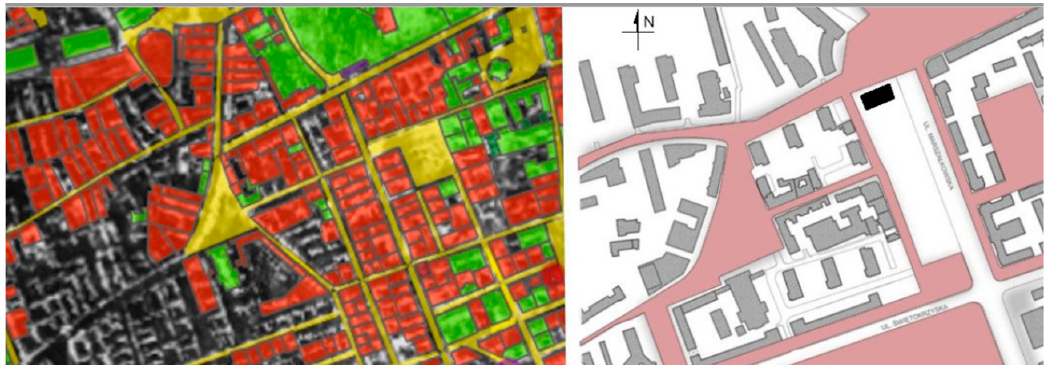
Figure 1. Comparison of the urban tissue. On the left—Before 1939. Legend: black—Remaining urban tissue; red—Destroyed urban tissue; green—Green public areas; yellow—Roads and public squares [29]. On the right—Contemporary state. Legend: grey—Existing buildings; white—Undeveloped areas; brown—Roads and public areas. Selected site is shown as a black rectangle.